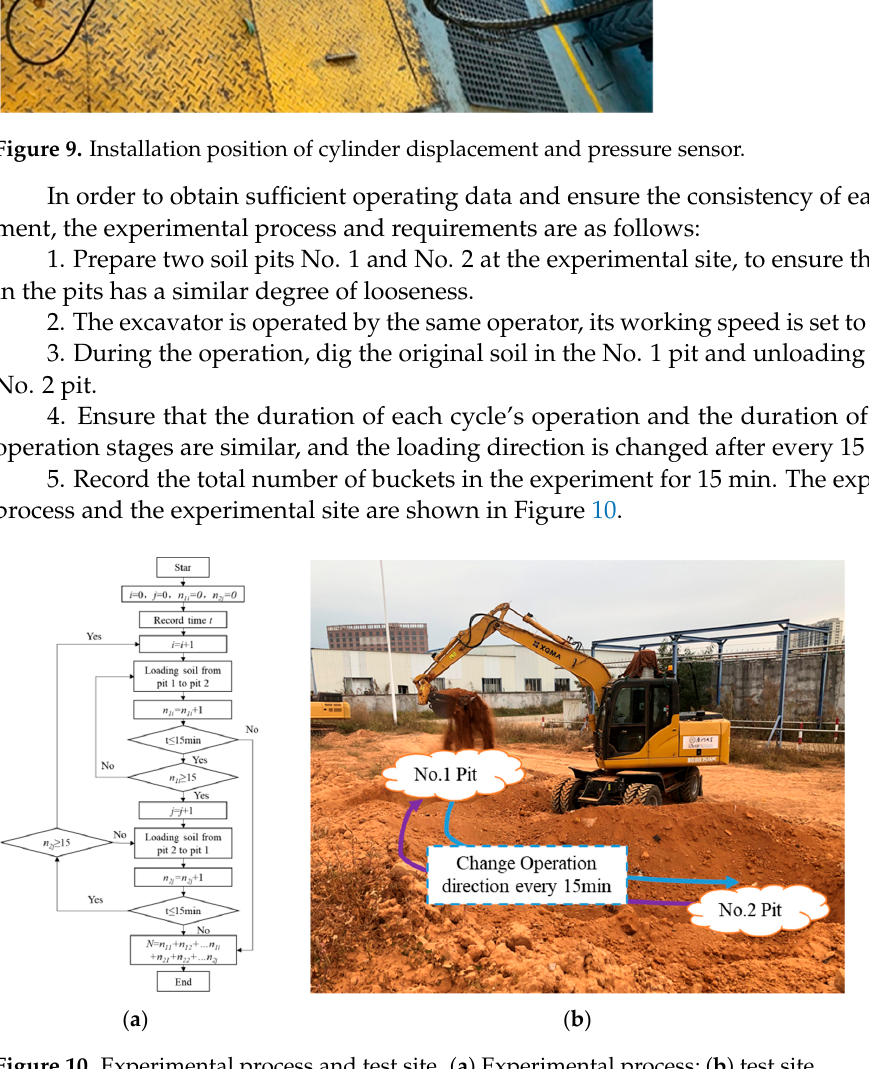
Figure 10. Experimental process and test site. ( a ) Experimental process; ( b ) test site. The experimental site for transportation conditions is a hard cement floor with a total length of 400 m. During the experiment, the engine speed was set at 2200 rpm, the gear was at the highest gear position, and the excavator was used for 30 cycles (12 km) without a load. Compared with the operation condition, the actuation system and the swing motor do not work in the transportation condition, and the data of the engine, torque converter, steering pump, and main pump are mainly collected. The collected data for transportation conditions are shown in Table 2. Table 2. Data collection under transportation condition. Serial Number